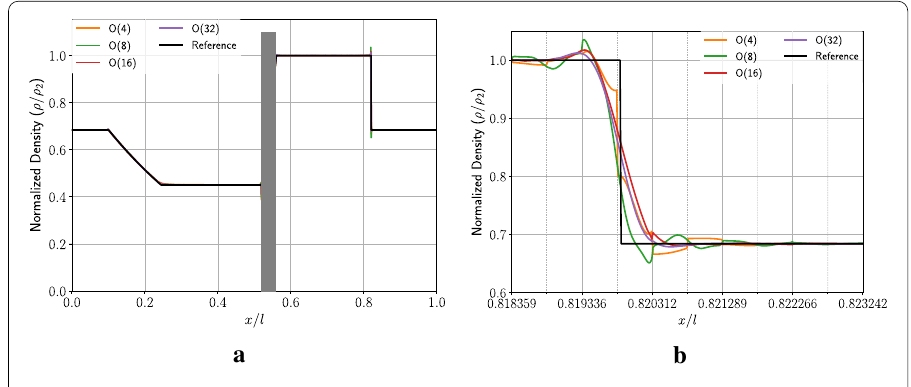
Fig. 9 Different curves represent different discretization using different scheme orders and elements. a Normalized density over the length of the domain. b Zoom of the shock area, in front of the shock